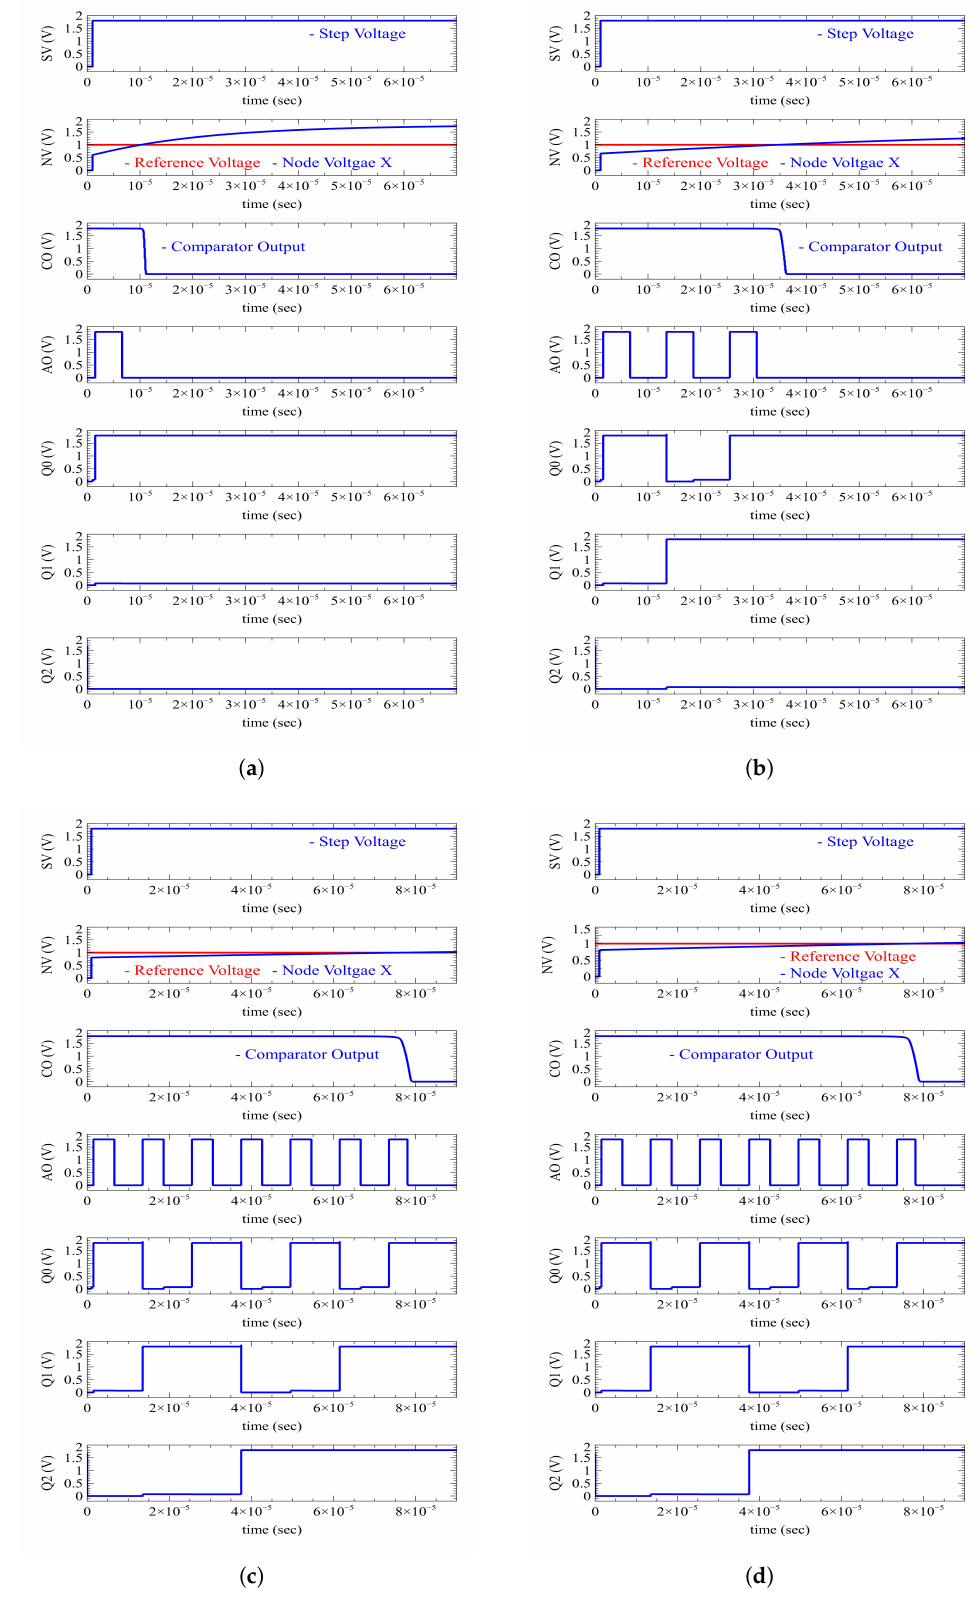
Figure 8. Control bits w.r.t load ( Z L ) variations. ( a ) When the load is 0.2 Z L . ( b ) When the load is 0.8 Z L . ( c ) When the load is 1.5 Z L . ( d ) When the load is 2.6 Z L